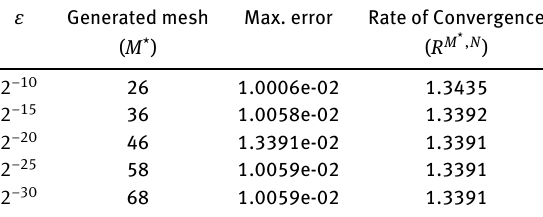
Fig. 3: Surface plot of example 5.1, using adaptive mesh for different values of ϵ , δ and η . Table 2: Maximum point wise errors of the solution and correspond- ing rate of convergence for Example 5.2 by taking δ = 0.6 , η = 0.7 , M=10 and N=20 for different values of ε